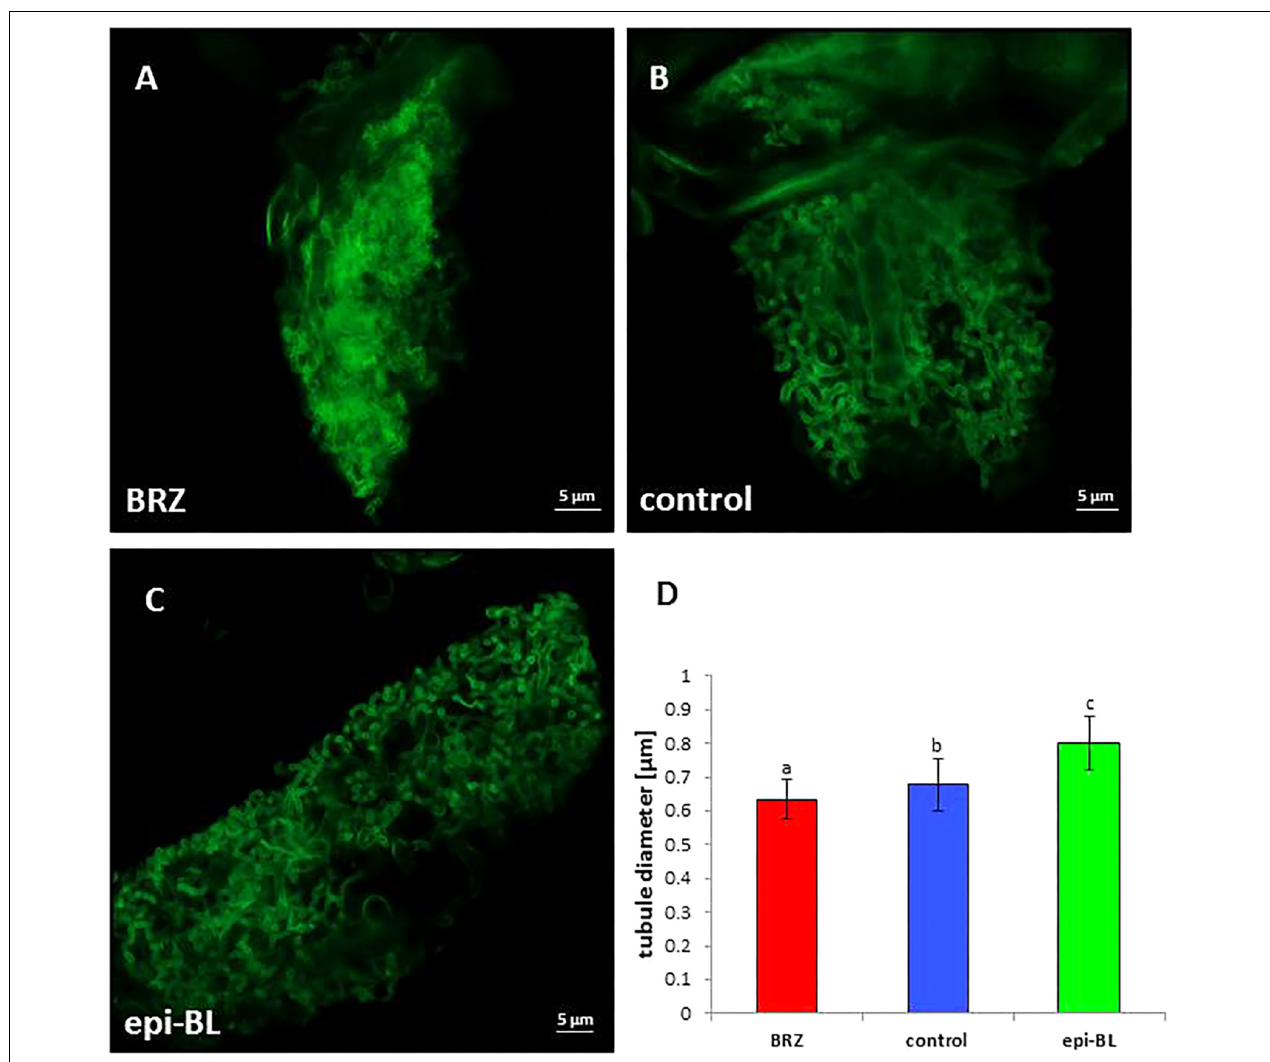
FIGURE 6 | Arbuscule morphology in tobacco wild type roots. Tobacco mycorrhiza treated with brassinazole (A) , with DMSO as control (B), or with epi-brassinolide (C) . Roots were stained with WGA-FITC and analyzed by CLSM. (D) Tubule diameter estimation determined with the ZEN 2.0 software. Mean values and SE are shown for 20–80 tubular branches from 15 different arbuscule replicates for each treatment. Significant differences between DMSO control and BRZ or epi-BL treatment were calculated by a one-way ANOVA and indicated by different letters (with P < 0.05). Scale bars are 5 µ m in